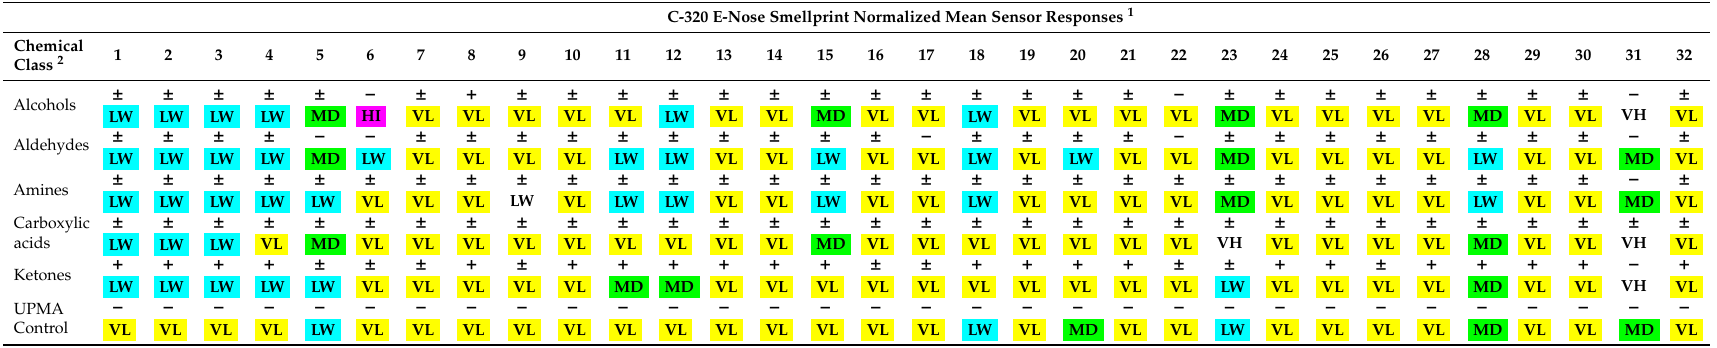
Table 2. Normalized mean sensor response intensity ranges within C-320 smellprint signatures of volatile organic compounds from five chemical